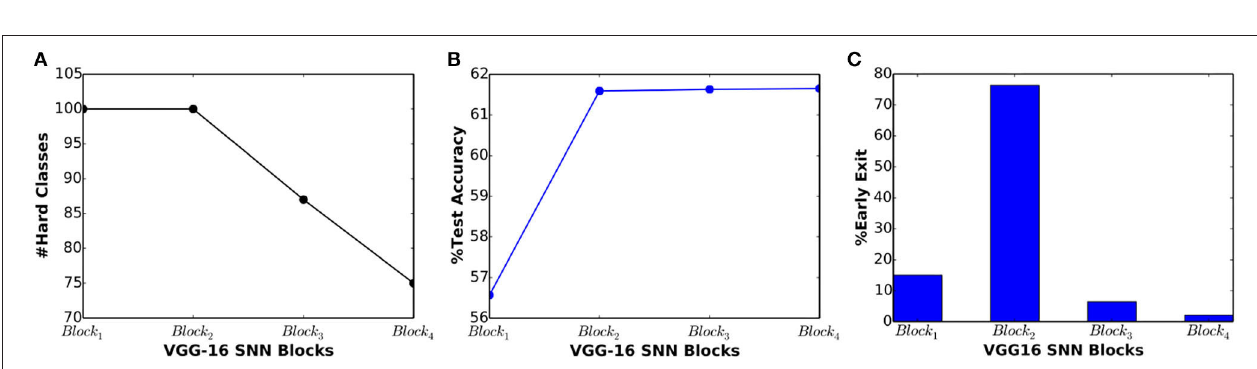
FIGURE 8 | Illustration of VGG-16 spiking neural network (SNN) divided into 4 blocks, where each block is trained sequentially using BlocTrain. The first block is trained on all the H 0 classes. Any subsequent block, Block i , is trained on the hard classes of Block i − 2 (denoted by H i − 2 in the figure). The final block receives residual connections from Block 1 and Block 2 to improve the training efficiency. The number of output feature maps and kernel size are specified for all the blocks. The stride is set to unity unless explicitly mentioned otherwise.